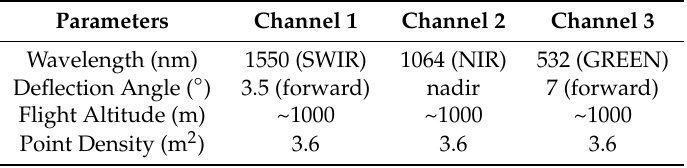
Table 2. Specifications of the Titan Airborne